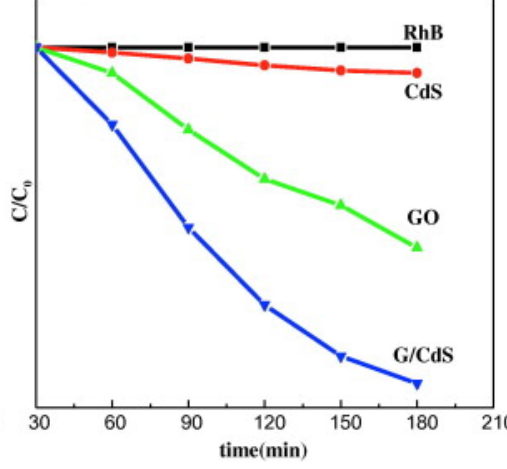
Figure 6. Degradation of Rh. B as a function of catalysis and irradiation time. Reprinted with copyright permission from reference [112]. Copyright © 2013, Elsevier.